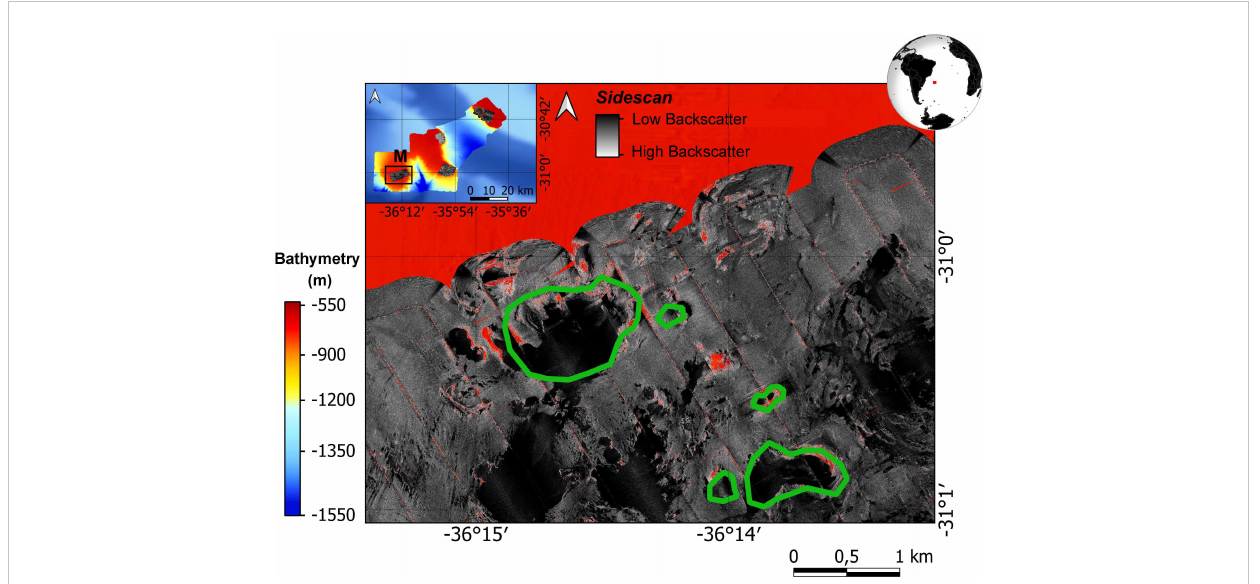
FIGURE 13 Zoom of the circular structures (shapes produced from the bathymetry) in green coinciding with the depressions (low albedo) found by the sidescan sonar